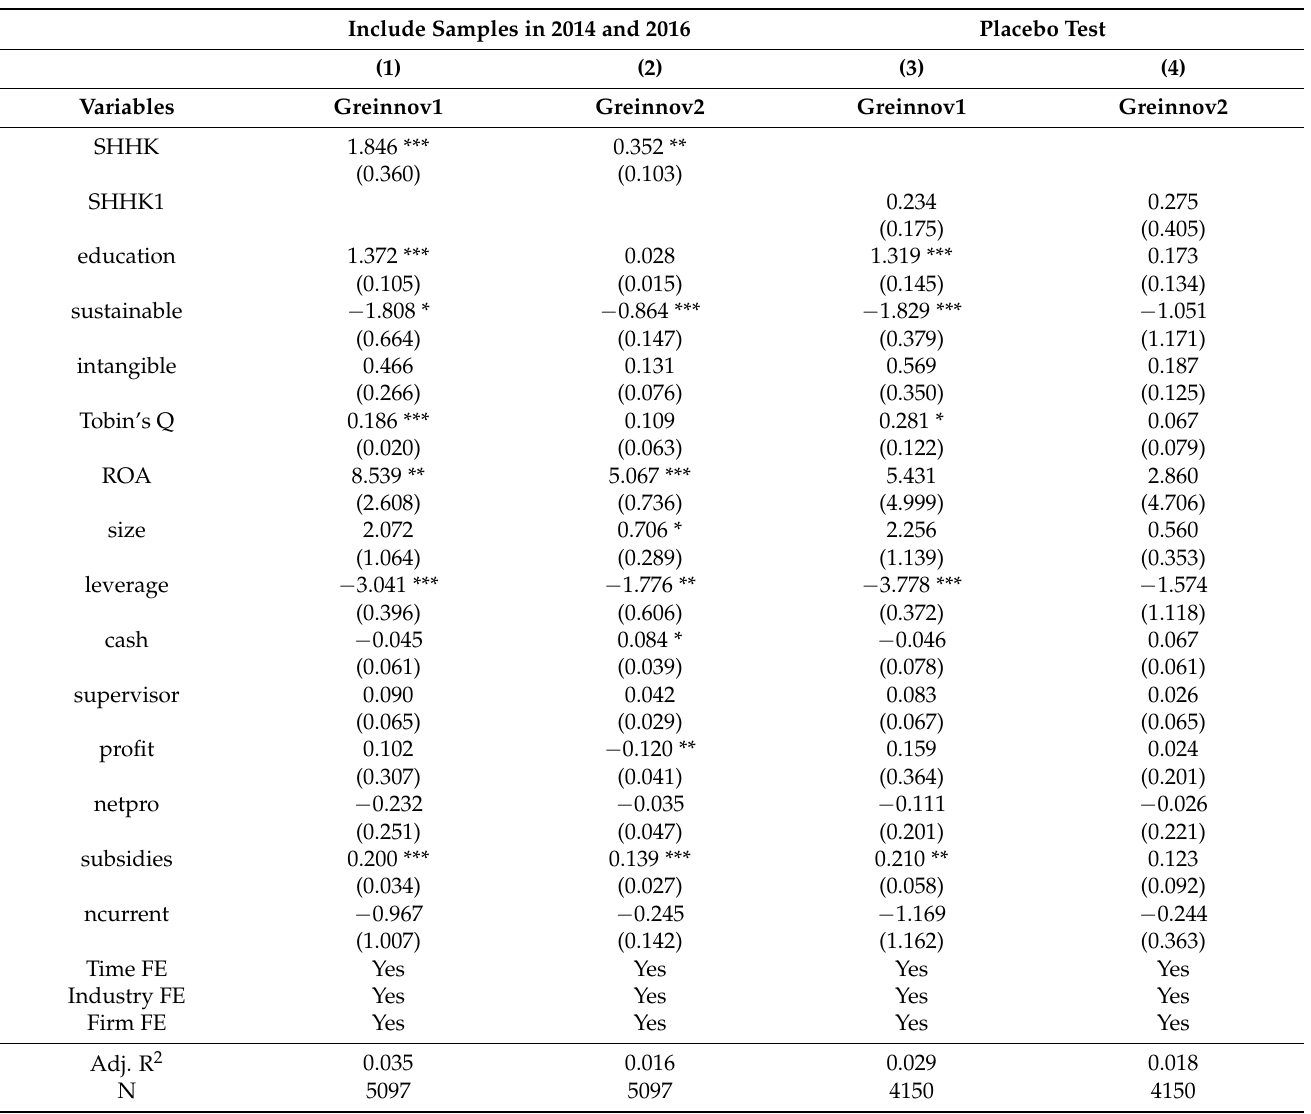
Figure 1. Standardized bias. Table 5. Regression results of robustness